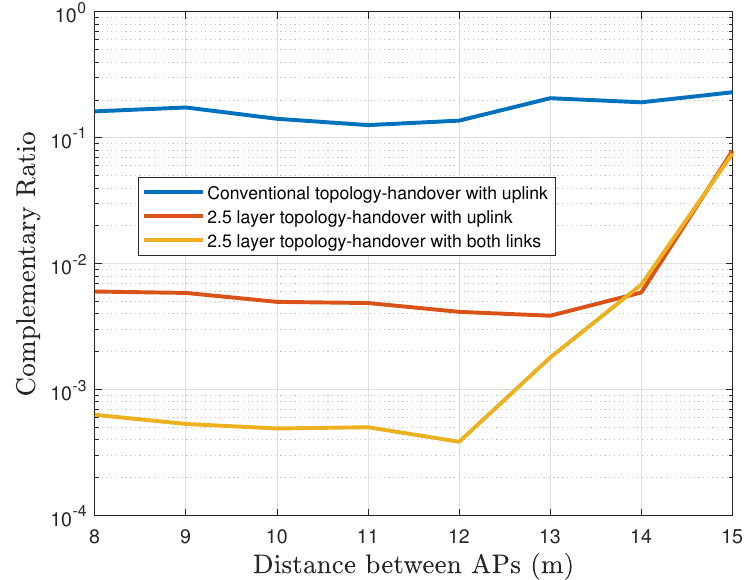
Figure 17. The outage ratio comparison (logarithmic scale).